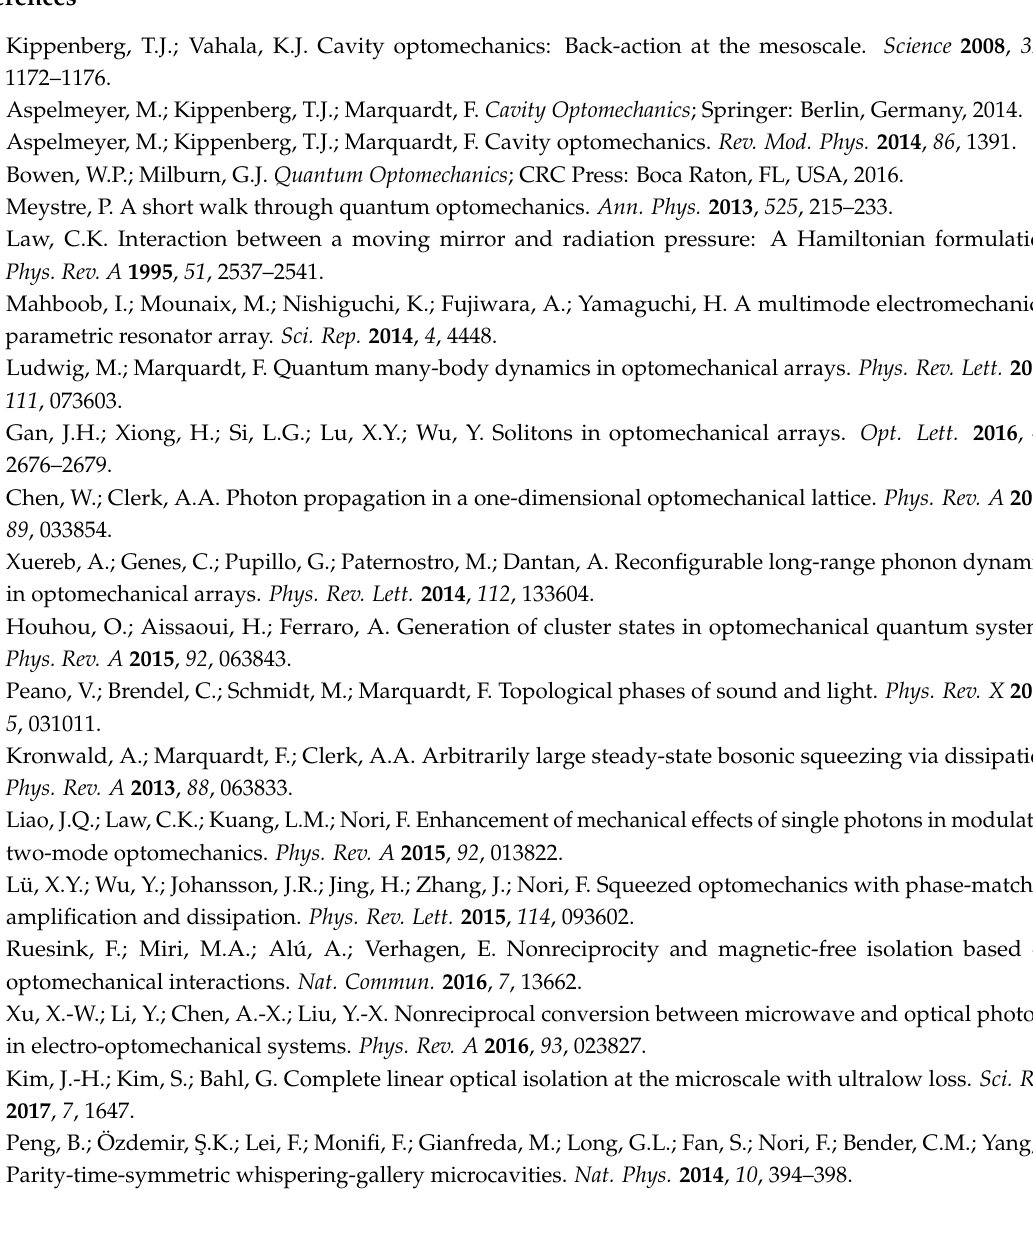
Figure S1: The stochastic solution function u ( t ) = (cid:104) ˆ u ( t ) (cid:105) versus time given in various orders of approximation, Figure S2: Expectation value function (cid:104) ˆ u ( t ) (cid:105) versus time given in various orders of approximation. Convergence to the exact solution obtained from numerical solution of (S4) is rapid by increasing